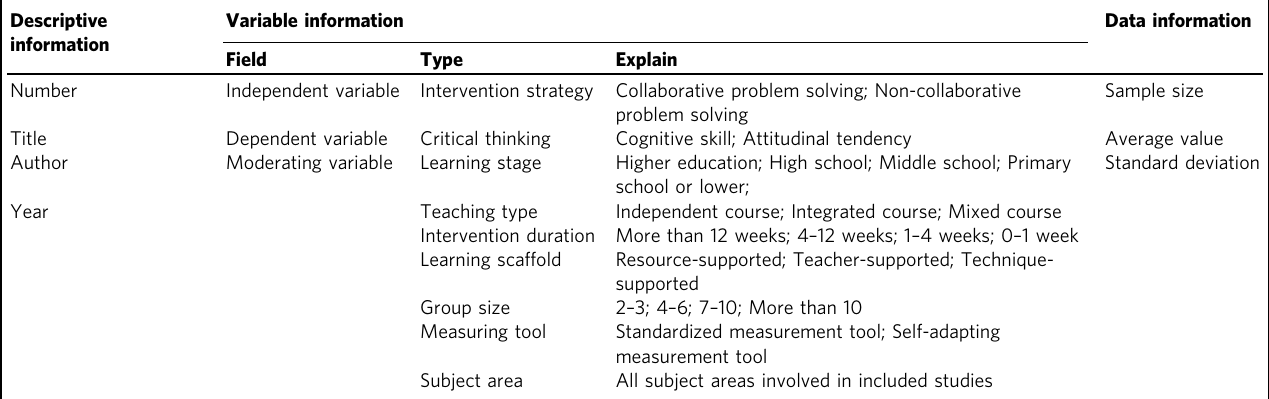
Table 1 The designed data coding